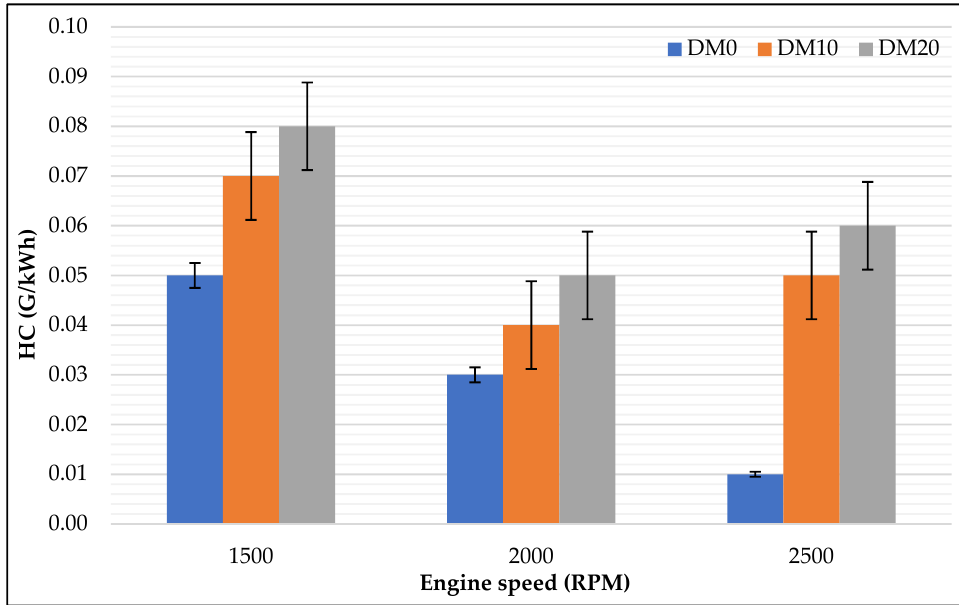
Figure 3. HC emissions at different engine speeds.